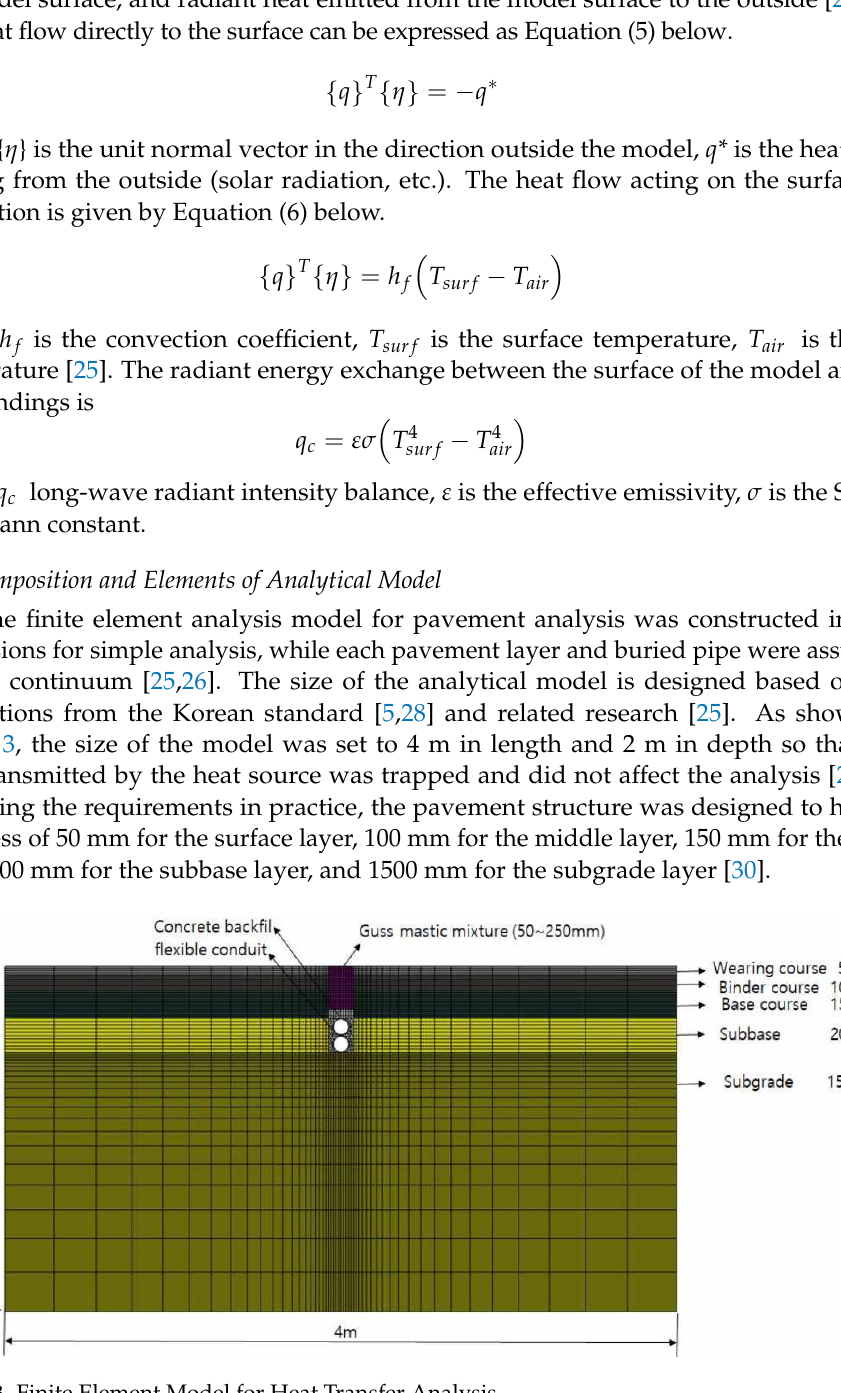
Figure 3. Finite Element Model for Heat Transfer Analysis.